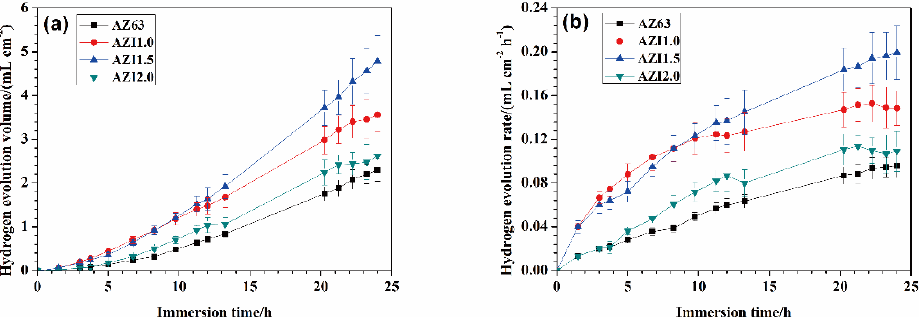
Figure 4. Hydrogen evolution volume ( a ) and hydrogen evolution rate ( b ) as a function of immersion time of Mg‐Al‐Zn and Mg‐Al‐Zn‐In alloys in 3.5 wt% NaCl at 25 ± 1 °C.